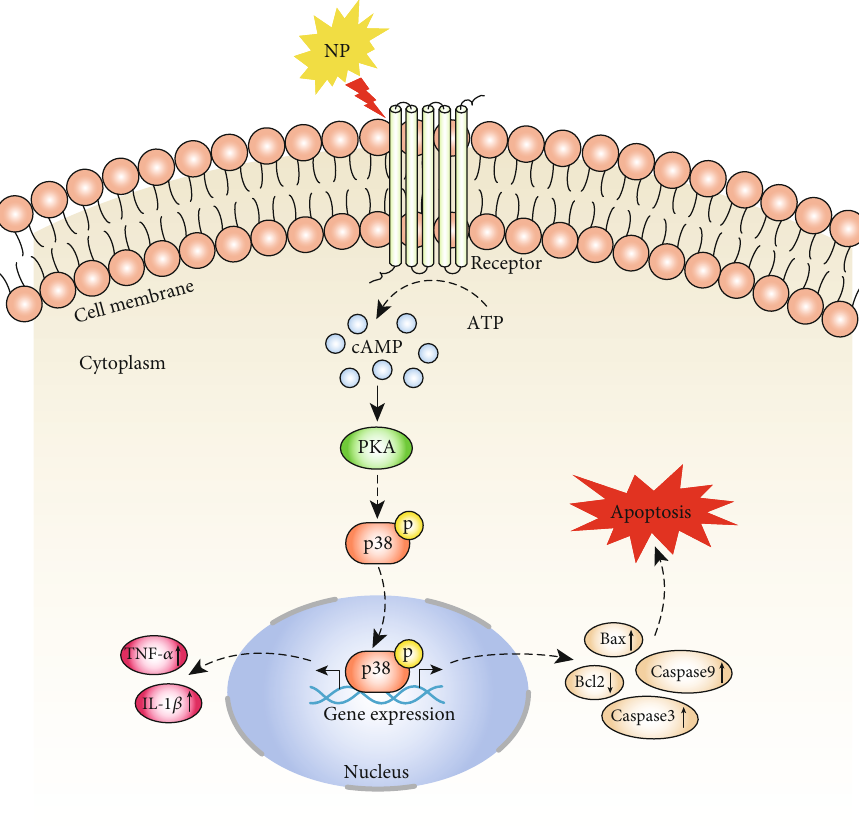
Figure 9: Schematic diagram showing that PKA is involved in neuropathic pain by activating the p38MAPK pathway to mediate spinal cord cell